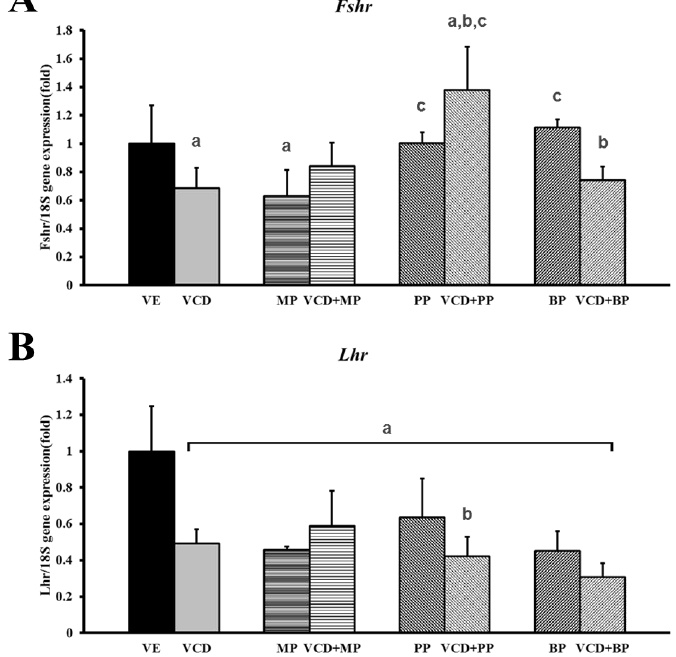
Figure 6. Effects of VCD and parabens on the mRNA expression of hormone receptors in rats ovaries. The expression of Fshr and Lhr gene were measured by performing real-time PCR, and normalized by Rn18s . ( A ) Fshr ; ( B ) Lhcgr . a p < 0.05 vs. VE, b p < 0.05 vs. paraben, c p < 0.05 vs. VCD. Data are presented as the mean ± SD. VE; 20% Et-OH, VCD 40 mg/kg/day, MP, PP, BP; 100 mg/kg/day.